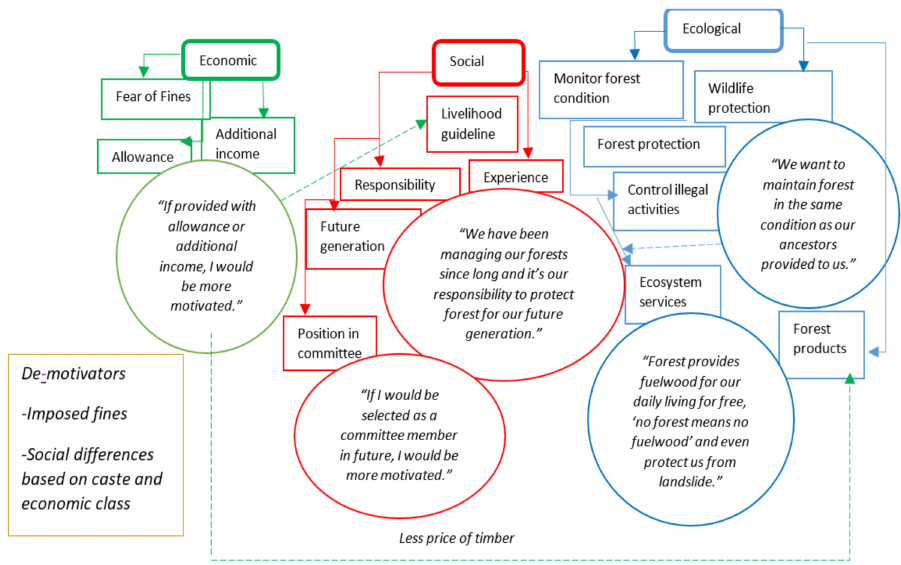
Figure 5. The web of drivers for forests users’ (de)motivation to participate in co-management.